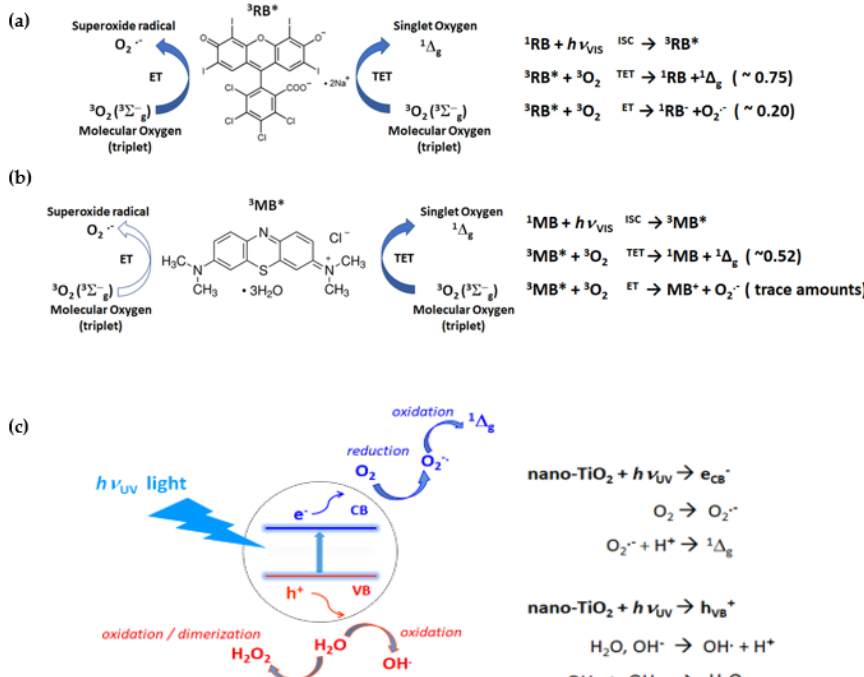
Scheme A1. (Left) Structures of organic and inorganic photosensitizers used in this study, i.e., of rose bengal, RB ( a ), methylene blue, MB ( b ) and nano-TiO 2, ( c ). (Right) Relevant reaction schemes of ROS generation processes. ET,